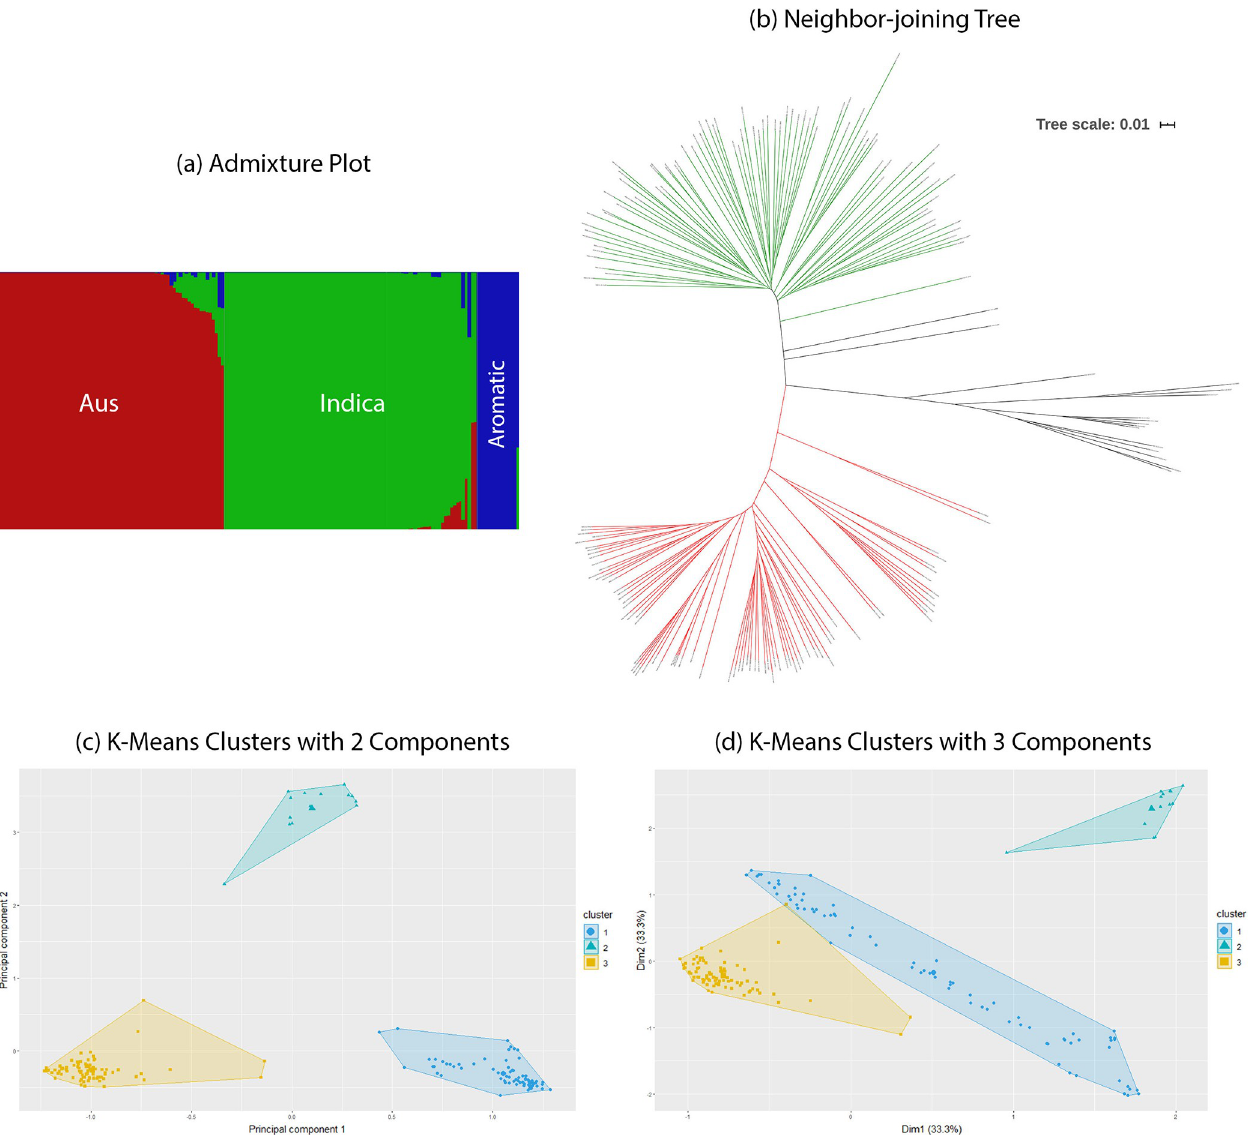
Fig 2. Population structure estimation results for 176 varieties. Three distinct subpopulations can be inferred from these diagrams. (a) An admixture plot calculated from fastStructure. (b) Neighbor-joining tree drawn from genotype data. The green individuals belong to the Aus subgroup, red individuals are from the Indica subgroup and black lines denote plants distant from these groups. (c) K-means clustering results of the first two principal components. (d) K-means clustering results of a three-dimensional plot of the first three principal components.